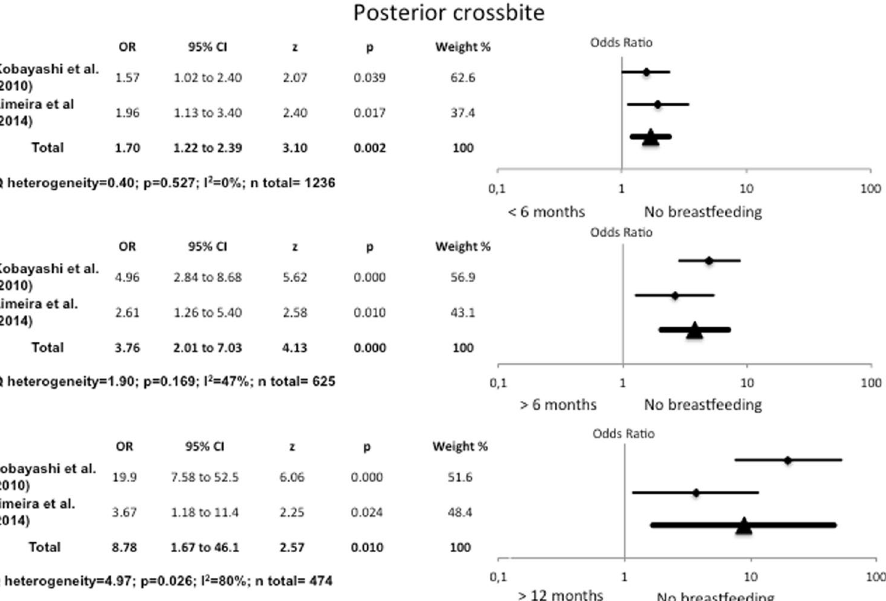
Figure 2. Odds Ratio for posterior crossbite, comparing no breastfeeding with breastfeeding for < 6 months, > 6 months and > 12